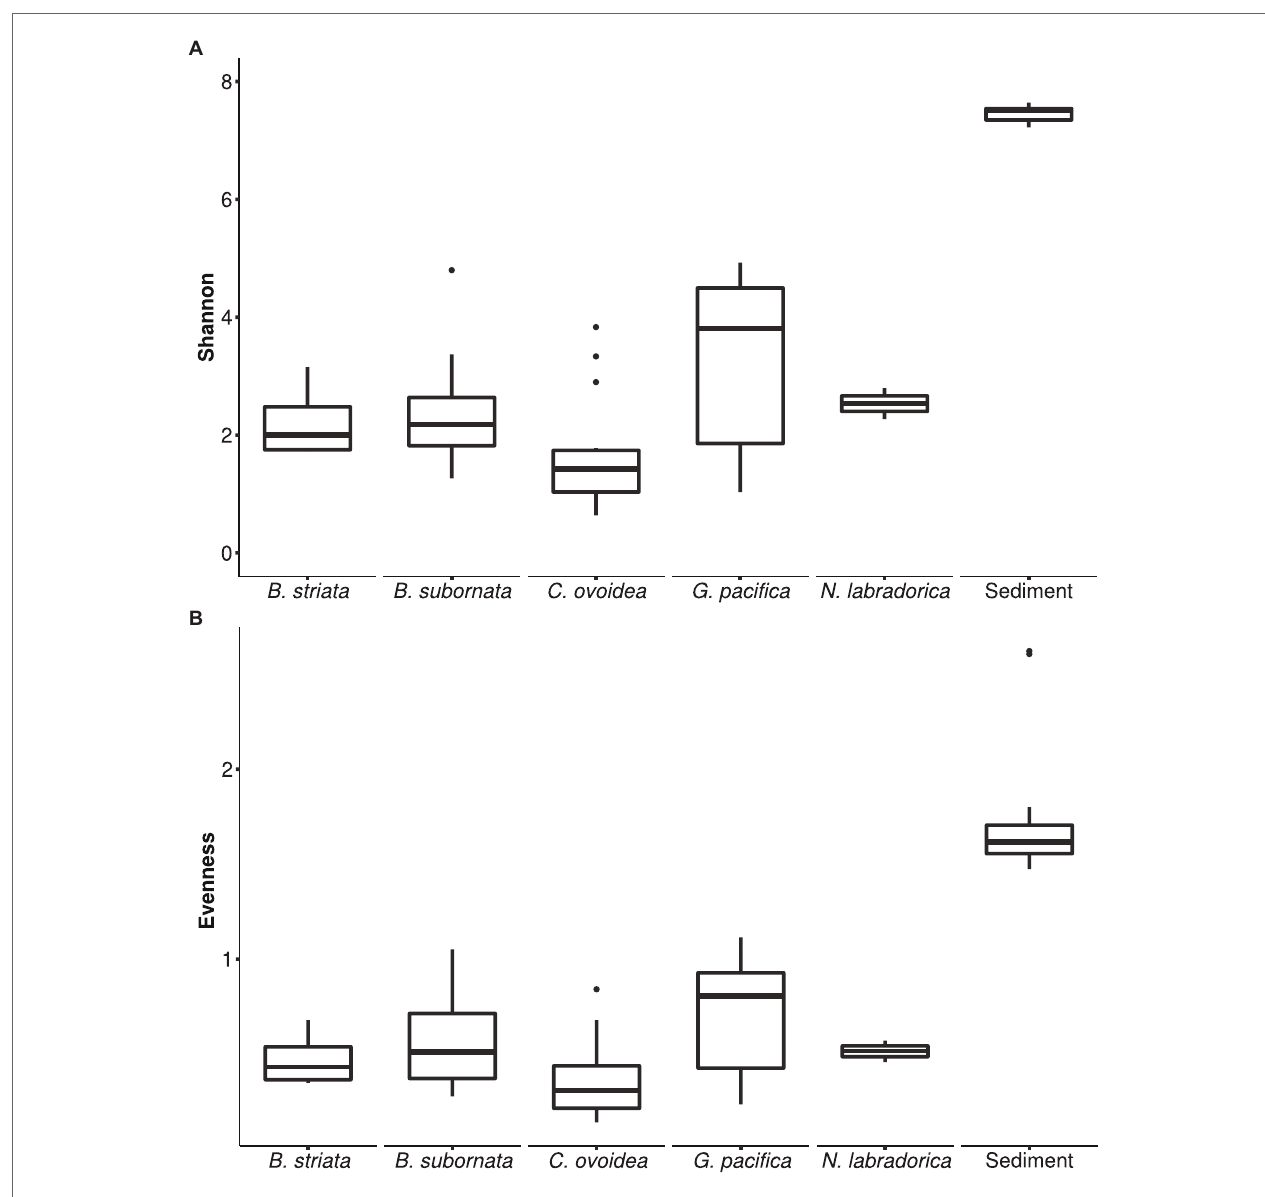
FIGURE 4 | Box and whiskers plot of microbiome alpha-diversity in foraminiferal species and sediment based on Shannon H ' index (A) and Pielou’s evenness index J ' (B) . The lower and upper hinges of the box correspond to the first and third quartiles, the line in between the median, and the whiskers extend to 1.5 times the interquartile range. Values outside this range are represented by black circles.